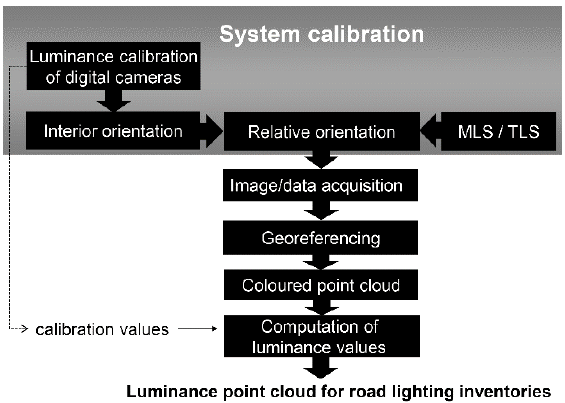
Figure 3. The workflow of combining luminance imaging and laser scanning approaches.